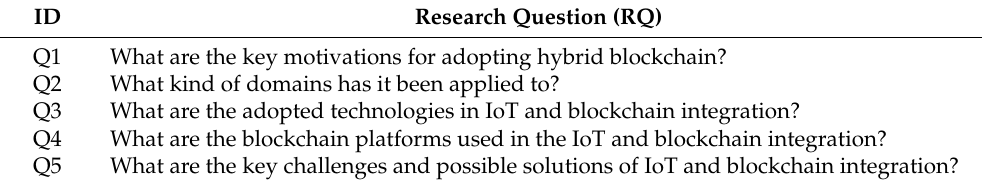
Table 1. Research questions